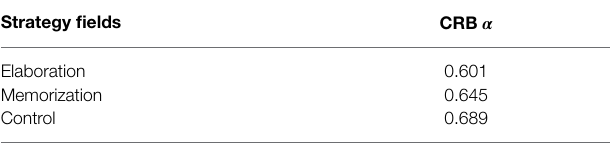
TABLE 2 | Internal consistency reliability (CRB) for strategy fields.